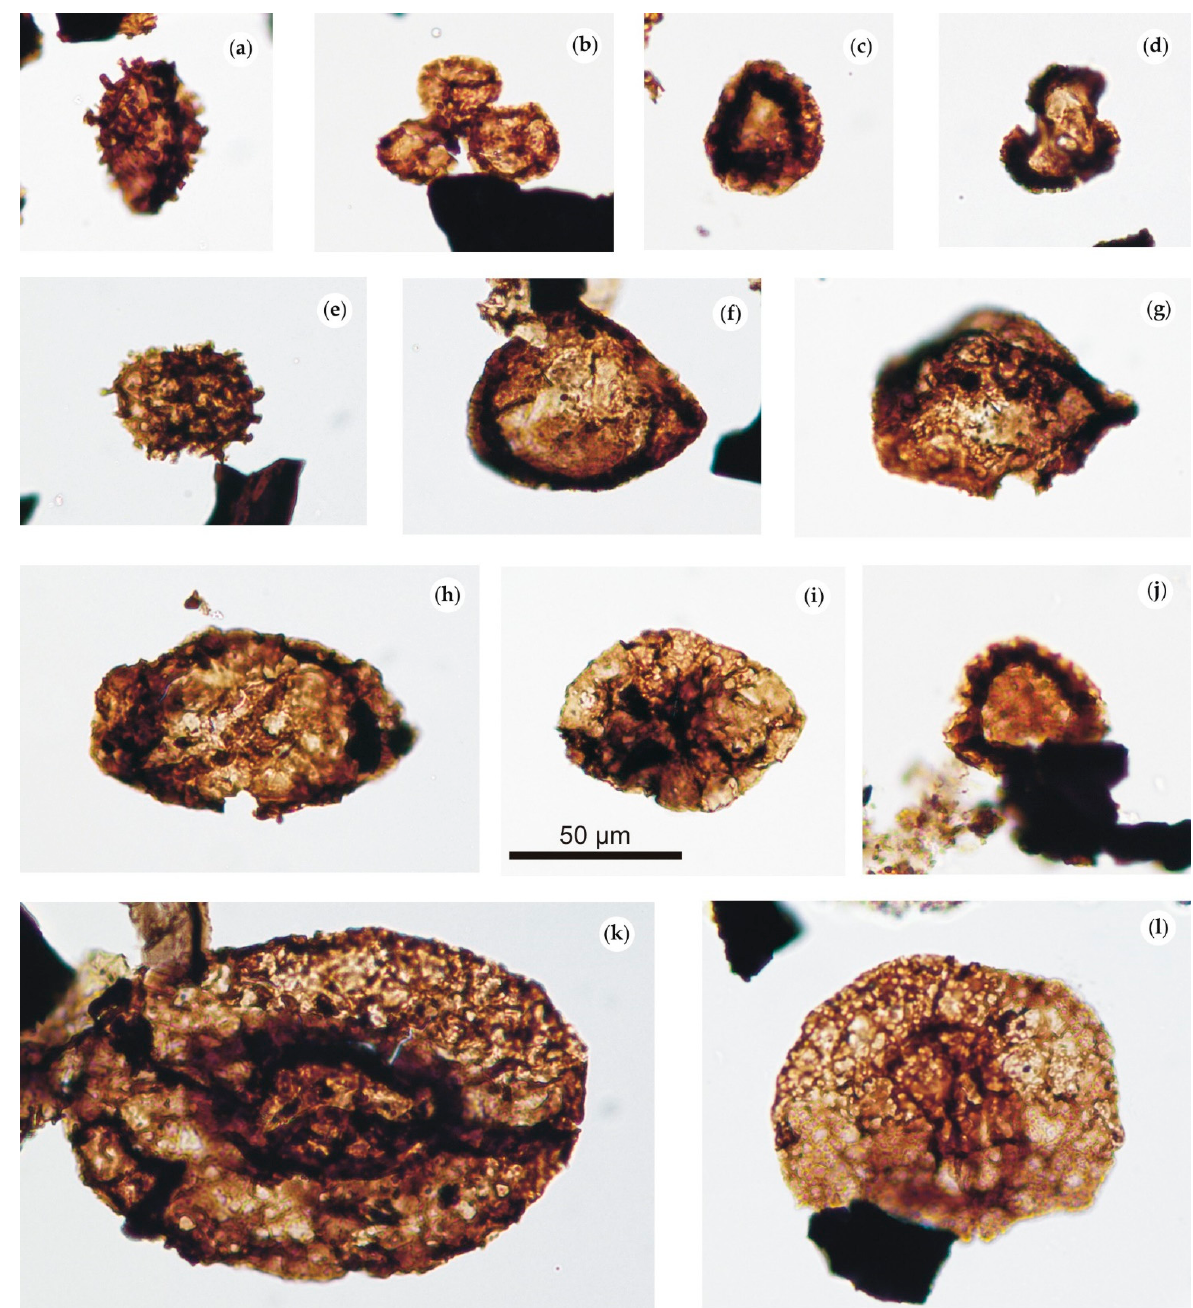
Figure 8. Microflora present in samples from northern (N samples) and southern (S samples) areas of the Jas-Mos mining area. ( a ) Raistrickia saetosa , sample N5; ( b ) Lycospora pusilla ?, sample N5; ( c ) Cingulizonates sp., sample N5; ( d ) Tripartites sp., sample S4; ( e ) Raistrickia saetosa , sample N1; ( f ) Crassispora kosankei , sample N1; ( g ) Crassispora kosankei , sample S4; ( h ) Schulzospora sp., sample N1; ( i ) Florinites sp., sample S4; ( j ) Cingulizonates bialatus , sample N8; ( k ) Florinites cf. visendus ., sample N1; ( l ) Florinites cf. pumicosus ., sample S2. Scale bar is the same for all images.